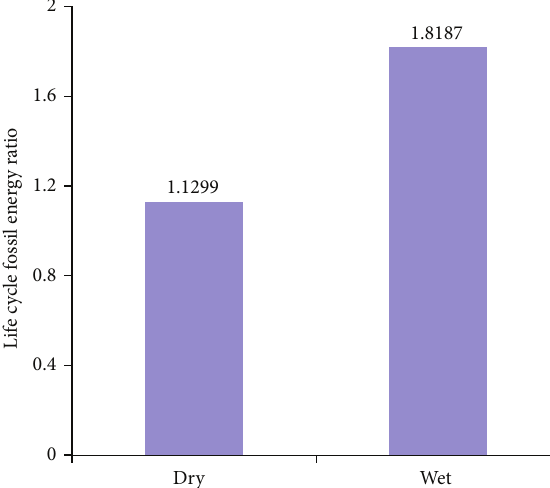
Figure5:Lifecyclefossilenergyratiofortheproductionofbiodiesel from Chlorellavulgaris growninnormalandlimitednitrogensupply conditions.